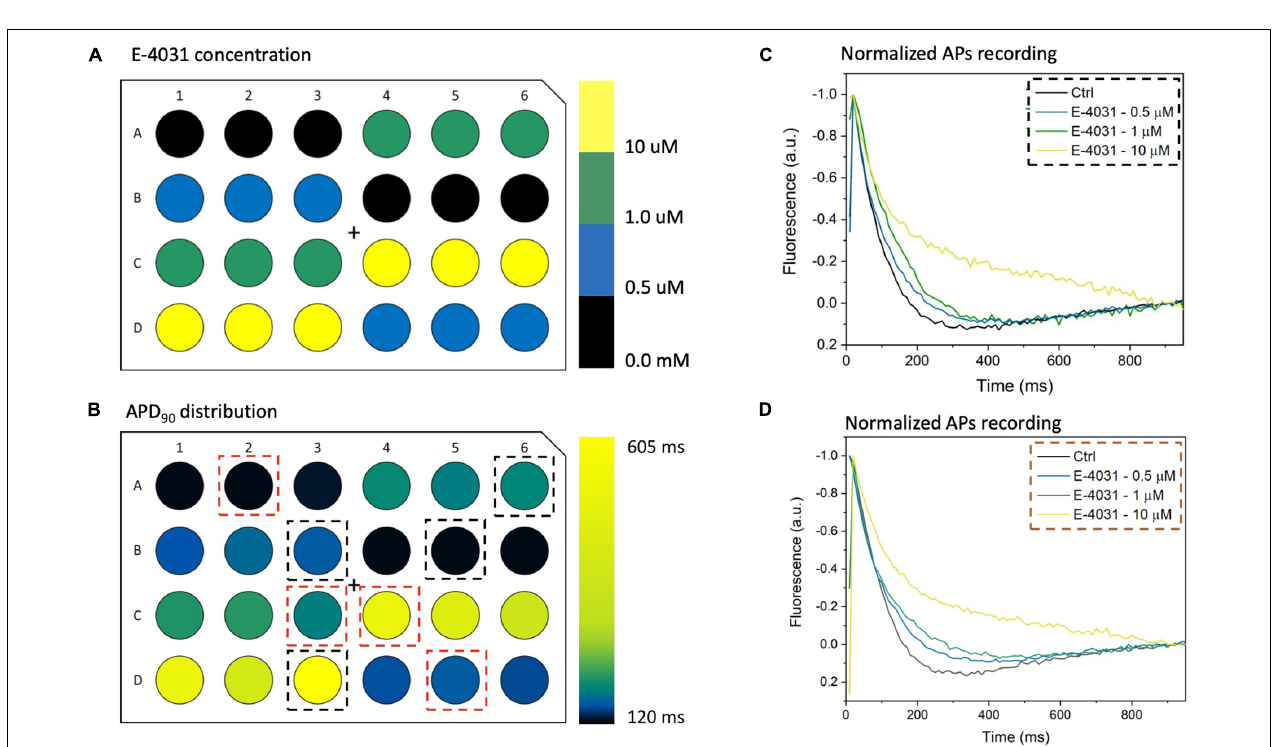
FIGURE 7 | Patch-clamp recording of AP in HL-1 cells. (A) Representative AP recording on a HL-1 cells using single cell patch-clamp (whole-cell configuration). APs were elicited at 0.2 Hz in current-clamp mode. (B) Table reporting average ± standard error of maximal diastolic potential (MDP), APA, APD 50 , and APD 90 measured in patch-clamp cells (number of cells = 15). APA, APD 50 , and APD 90 measured with MULTIPLE (pulses duration of 30, 40, and 50 ms) at the same stimulation frequency (0.2 Hz) are reported for direct comparison.